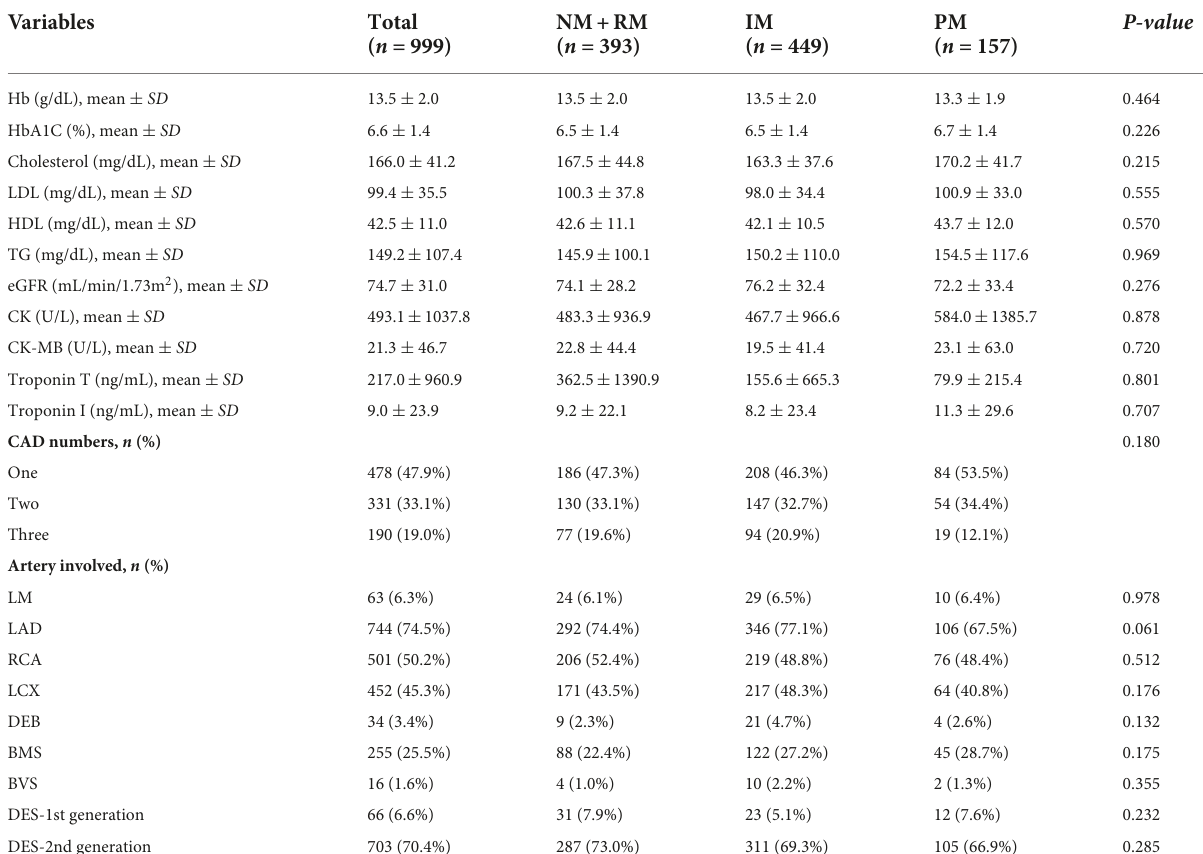
TABLE 3 Baseline laboratory and angiographic characteristics.